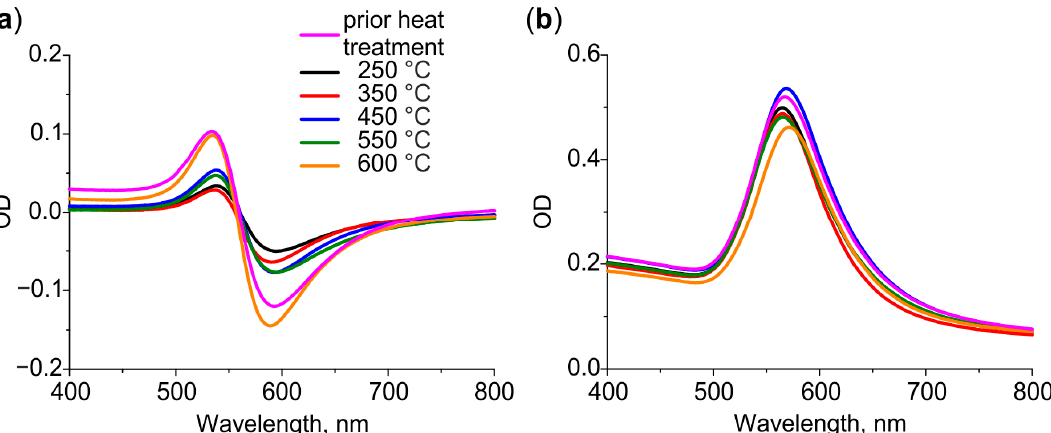
Figure 3. ( a ) Differential and ( b ) bulk spectra of glasses containing Au NPs after heat treatment in air at 250–600 °C. at 250–600 ◦